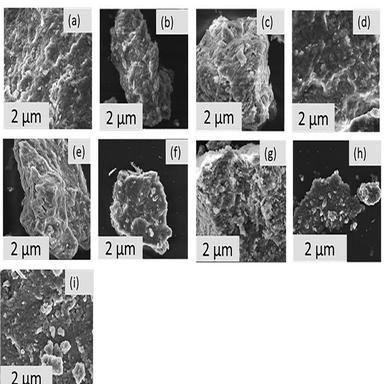
SEM images of (a) Ni0.95Mg0.05(OH)2, (b) Ni0.9Mg0.1(OH)2, (c) Ni0.75Mg0.25(OH)2, (d) Ni0.5Mg0.5(OH)2, (e) Ni0.95Mn0.05(OH)2, (f) Ni0.9Mn0.1(OH)2, (g) Ni0.75Mn0.25 (OH)2, (h) Ni0.5Mn0.5(OH)2, and (i) un-doped Ni(OH)2.